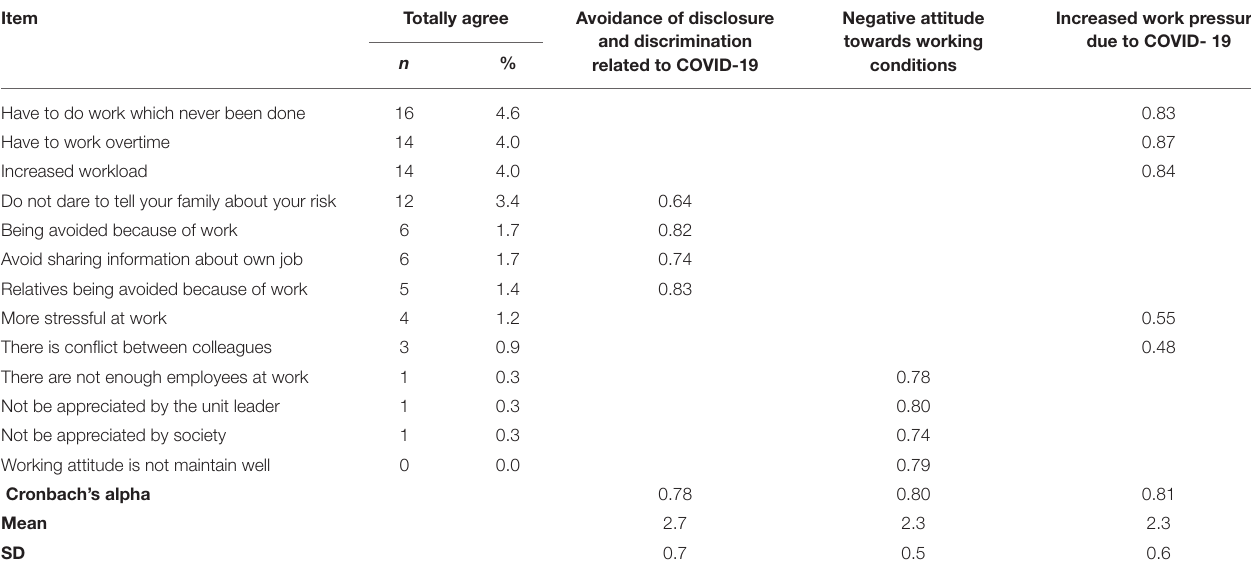
TABLE 2 | Impact on life and work of respondents due to COVID-19. Item